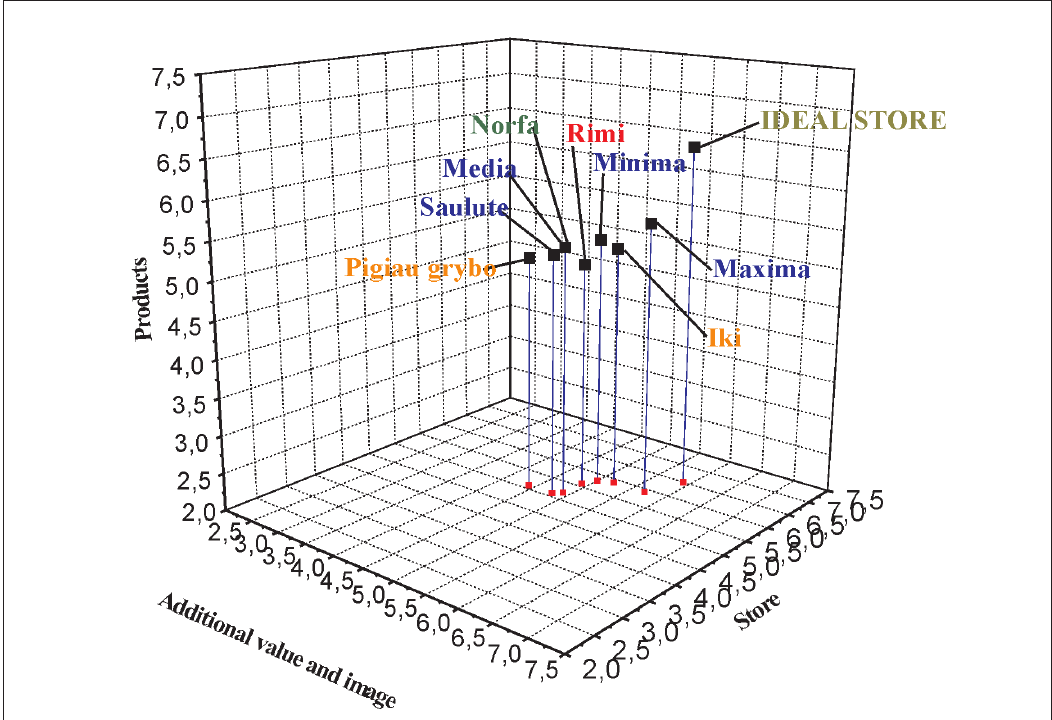
Fig 1. Positions of multiple retailers in three-factors customers’ perceptual